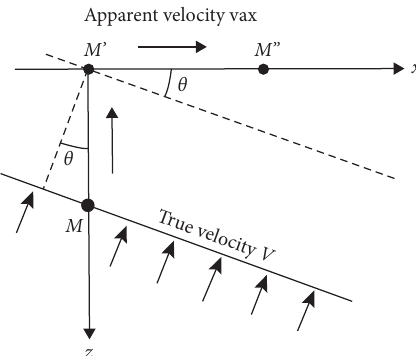
Figure 14: Apparent propagation of a shear